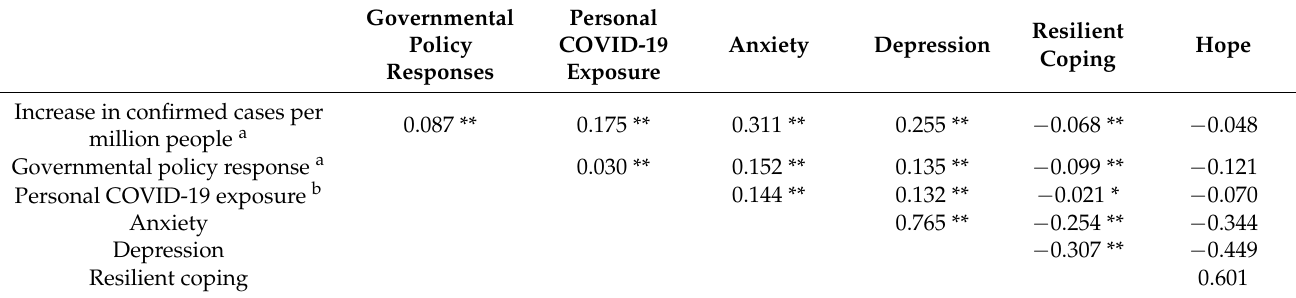
Table 2. Zero-order correlation between country-level COVID-19 factors, personal COVID-19 exposure, and mental health outcomes. among participants in the 11